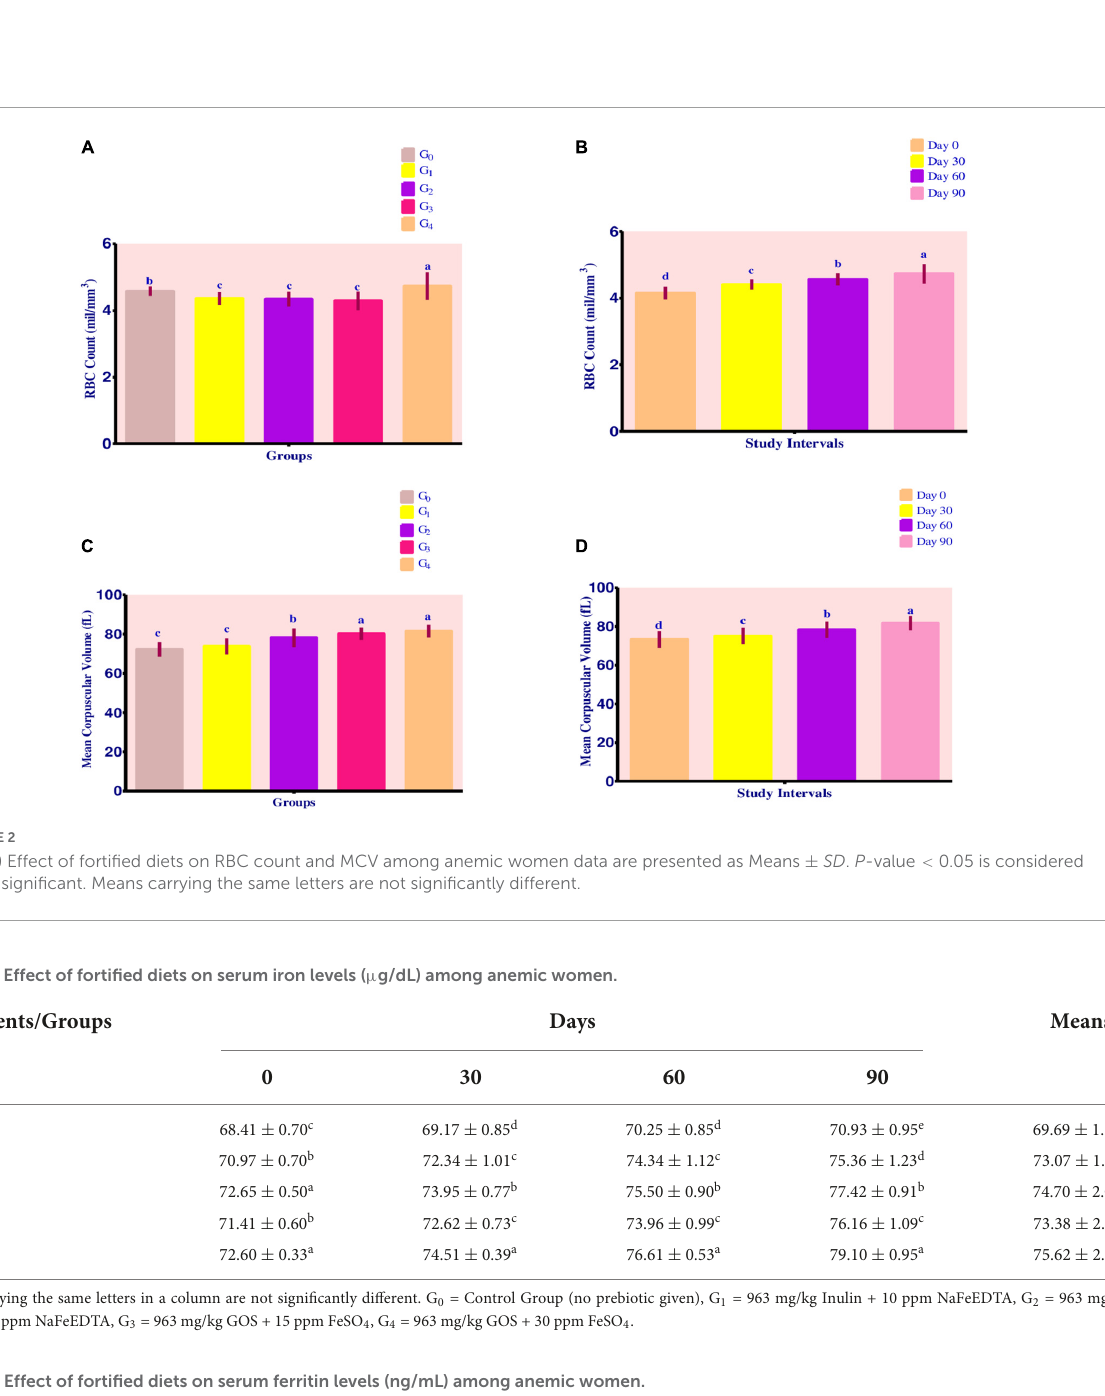
TABLE 6 Effect of fortified diets on serum ferritin levels (ng/mL) among anemic women. Treatments/Groups Days Means 0